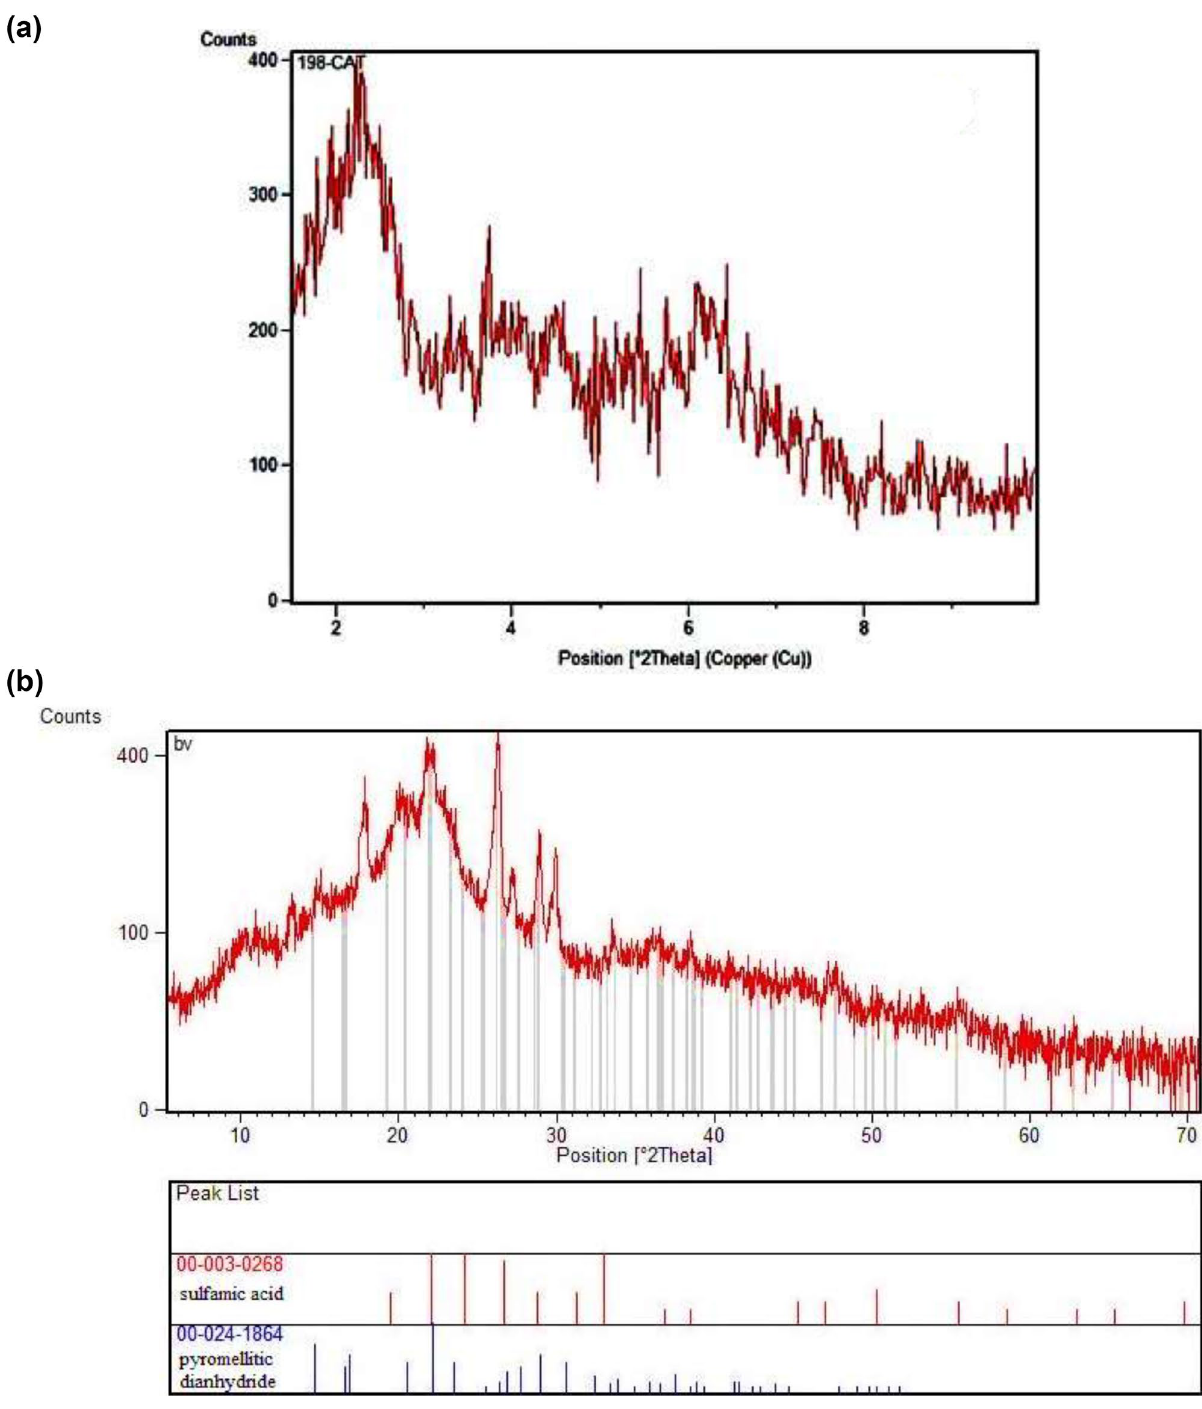
Figure 5. Low angle ( a ) and wide angle ( b ) XRD patterns of the hybrid MCM-41-APS-PMDA-NHSO 3 H nanocatalyst ( 1 Fig. 7. Interestingly, only a very little decrease in the catalytic activity of the MCM-41 (MCM-41-APS-PMDA- NHSO 3 H ( 1 , approx. 10%) was observed. To illustrate the merits of catalytic activity of the new MCM-41-APS-PMDA-NHSO 3 H organosilica nano- materials, as a heterogeneous solid acid, its efficiency has been compared with some of the previously reported catalysts for the preparation of 5a (Table 3). The results illustrate that this study is actually superior to other cases in terms of desired product yield, amount of catalyst loading, reaction time, working under solvent-free conditions, avoiding of the use of corrosive or expensive reagents and transition metals, and the reusability of the catalyst for at least five consecutive runs.